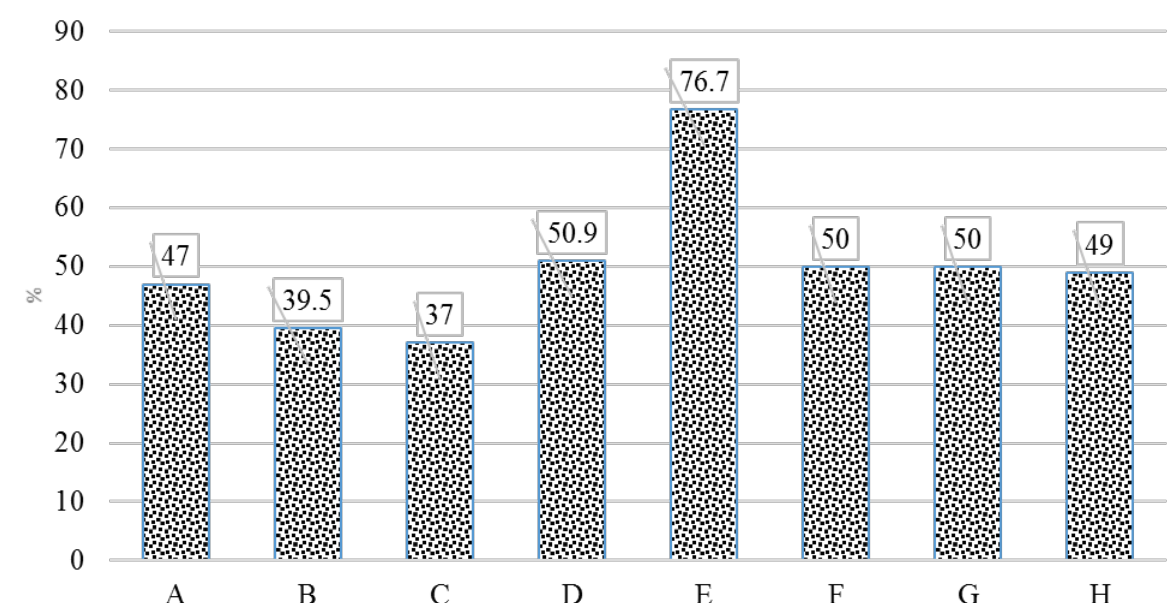
Fig. 1. Mechanisms of children’s psychological protection: A– exclusion; B – regression; C –substitution; D – refusal; I – projection; F – compensation; G – hyper-compensation; H – Table . Kinds of psychological protection Kinds of psychological